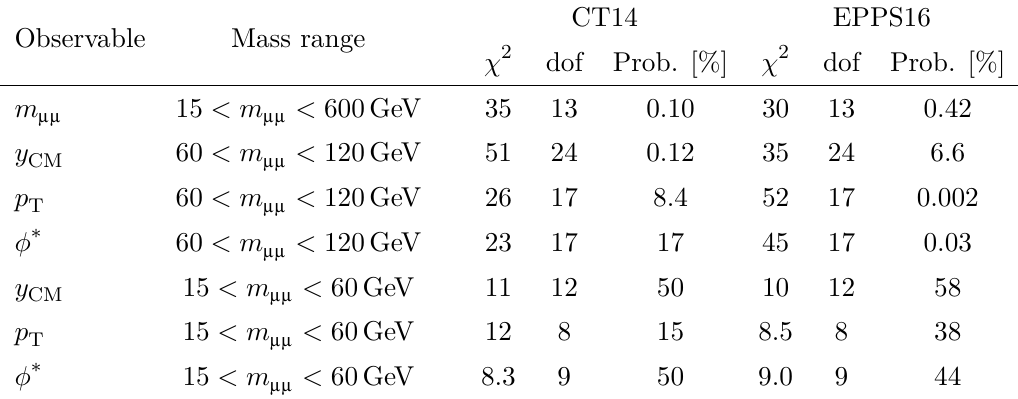
Table 2 . χ 2 values between the data and the powheg predictions and associated probability, from the fiducial cross sections, when experimental and theoretical bin-to-bin correlations are taken into account. The integrated luminosity uncertainty is included in the experimental